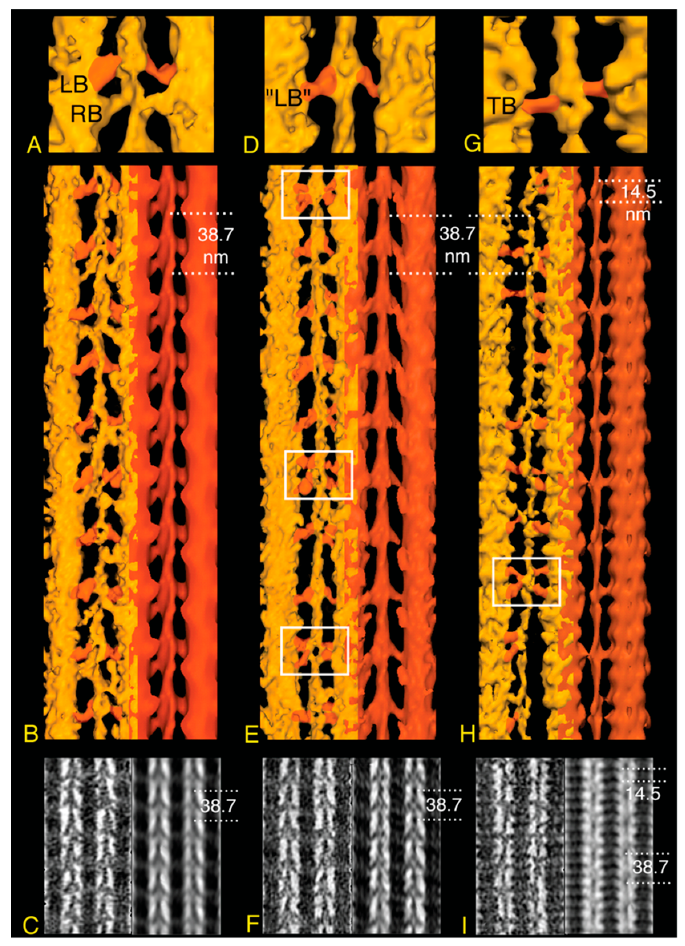
Figure 4. Tomographic image reconstructions of IHM in three equilibrium states: Rigor ( A – C ), aqueous AMPPNP at 23 ◦ C ( D – F ) (from [62]) and the glycol-AMPPNP at 5 ◦ C (from [63]) ( G – I ); ( A , D , G ) surface renderings of a single 38.7 nm actin period with attached cross-bridges; ( B , E , H ) surface renderings of a larger area; ( C , F , I ) projections of a region of the tomograms. The orientation has the Z-disc on the bottom. In ( B , E , H ), the column-averaged filament is shown in red to the right of the unaveraged filaments (gold) on the left. Target zone cross-bridges are colored red for ease of identification. The comparison clarifies the main differences among the three states; ( A – C ) the rigor state shows well-ordered, double chevrons consisting of lead- and rear-bridge pairs every 38.7 nm. There is no 14.5 nm periodicity visible on the myosin filament surface; ( D – F ) in aqueous-AMPPNP, the lead bridge motif every 38.7 nm is retained, often appearing single-headed, while rear bridges become disordered. Weak 14.5 nm periodicity can be seen on the myosin filament surface. White boxes outline mask motifs; ( G – I ) the glycol-PNP state shows single-headed attached cross-bridges every 38.7 nm, but their size, shape, and attachment angle generally differs from the rigor and AMPPNP lead bridges. A mask motif is outlined by the white box. The myosin filament surface reveals a strong 14.5 nm repeat of cross-bridge shelves. ©1997 Schmitz et al. Originally published in Journal of Cell Biology. https://doi.org/10.1083/jcb.139.3.695.